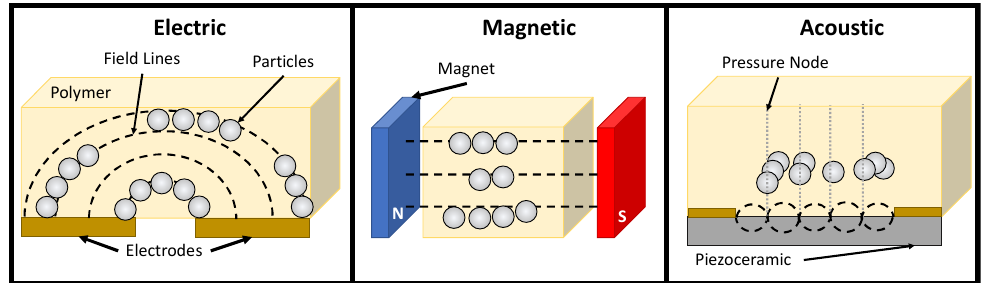
Figure 1. The diagram shows the three major types of external field mechanisms used in AM processing of particle-polymer composites.